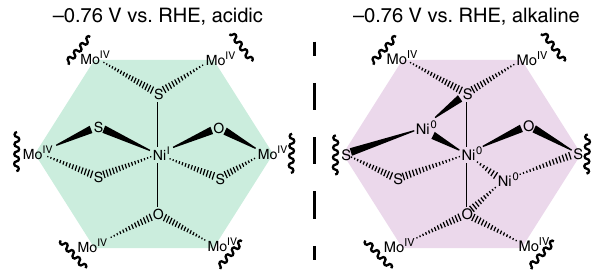
Fig. 6 The proposed Ni@1T-MoS 2 active species. The active species under acidic (left) and alkaline (right) conditions. Under alkaline conditions, the structure shown is representative, and the Ni 0 cluster size is further discussed in the